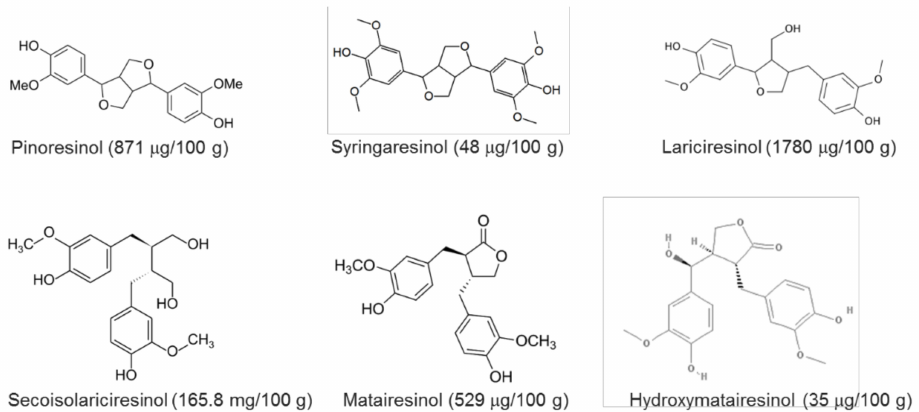
Figure 3. Chemical structures and amounts of some lignans in flaxseed. Lignin concentrations were taken from